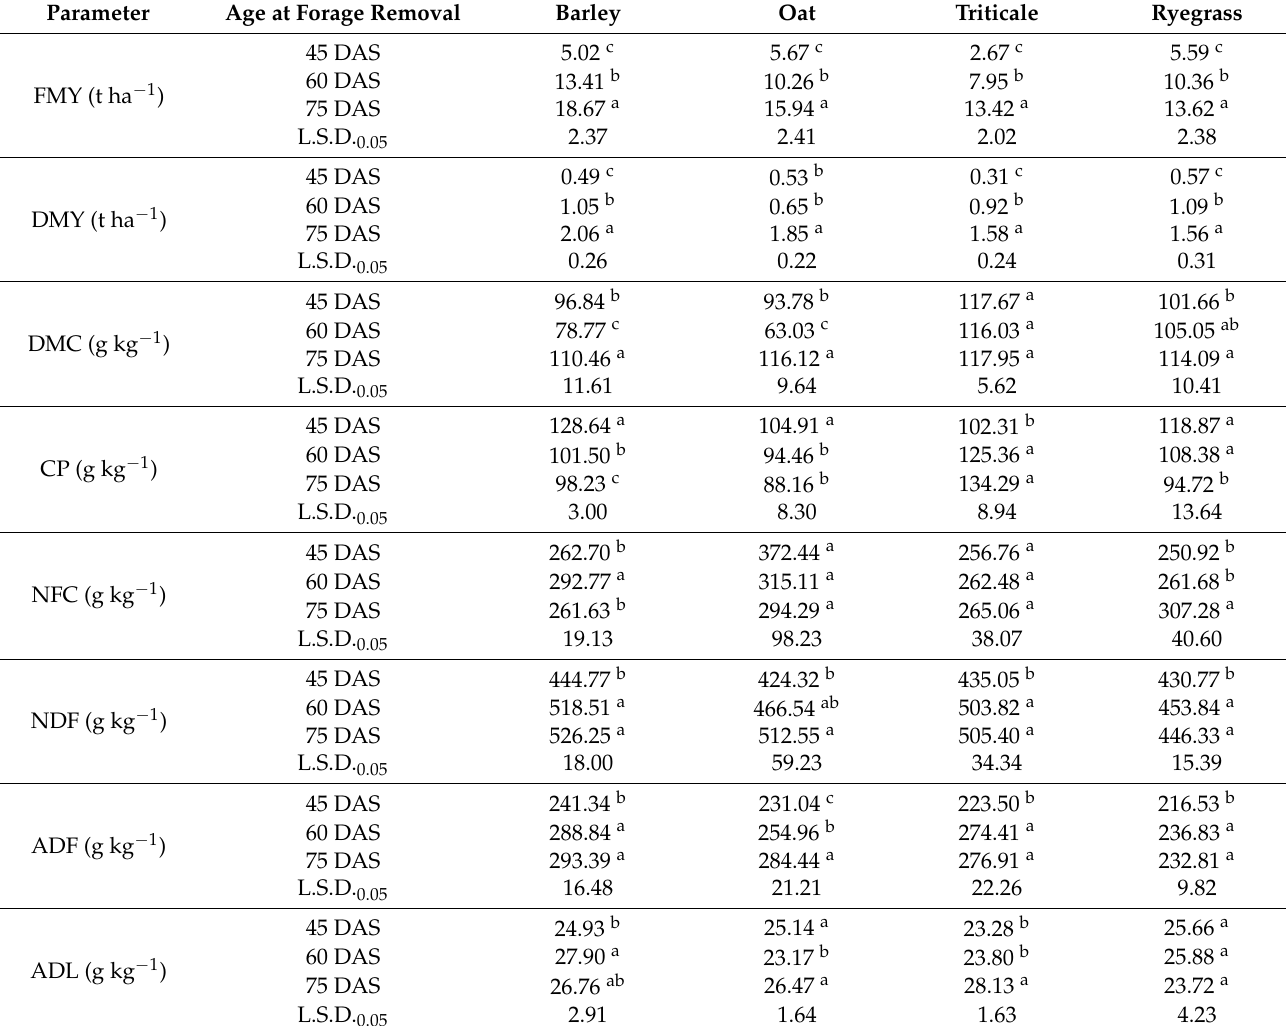
Table 1. Means of fresh matter yield (FMY), dry matter yield (DMY), dry matter content (DMC), crude protein (CP), non-fiber carbohydrates (NFC), neutral detergent fiber (NDF), acid detergent fiber (ADF), and acid detergent lignin (ADL) contents of the forage of the four crops as affected by the age at forage removal